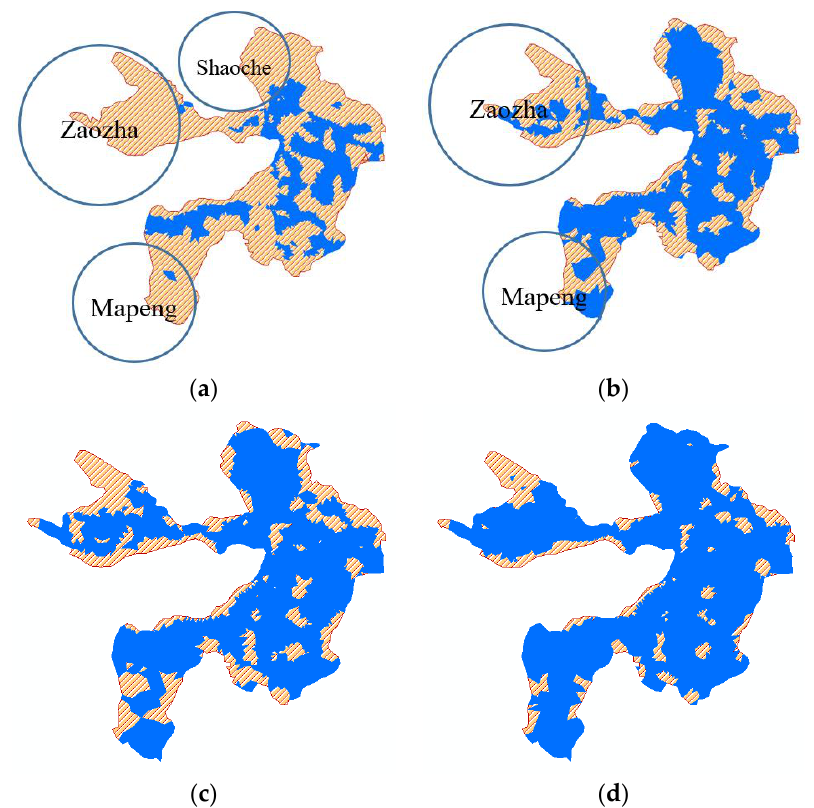
Figure 8. Landscape patterns under lake levels of ( a ) 6.2 m, ( b ) 7.4 m, ( c ) 7.8 m and ( d ) 8.4 m. Blue indicates the extent of water, and shading is used to indicate unsubmerged villages and reed lands.